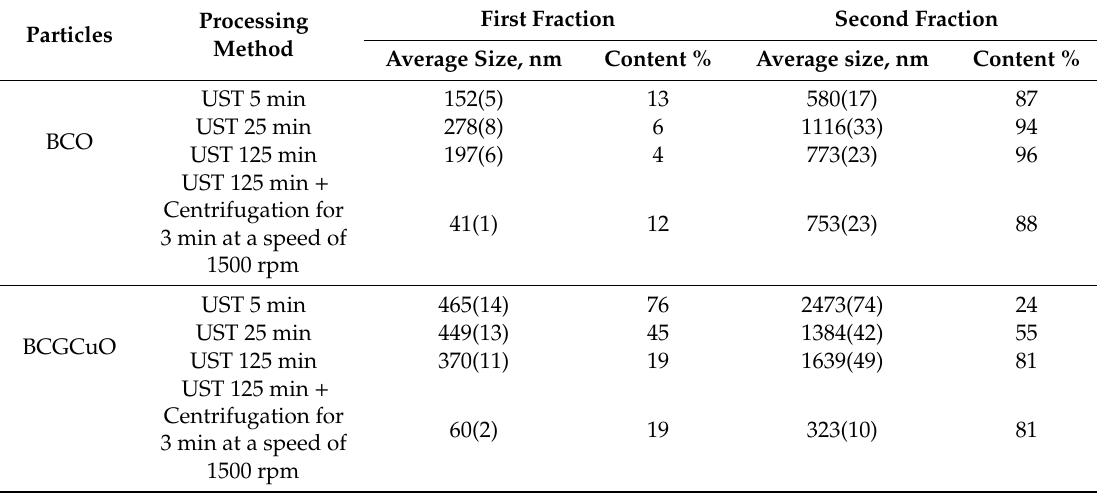
Table 1. The results of the fractional composition of suspensions of micro-sized BCO and